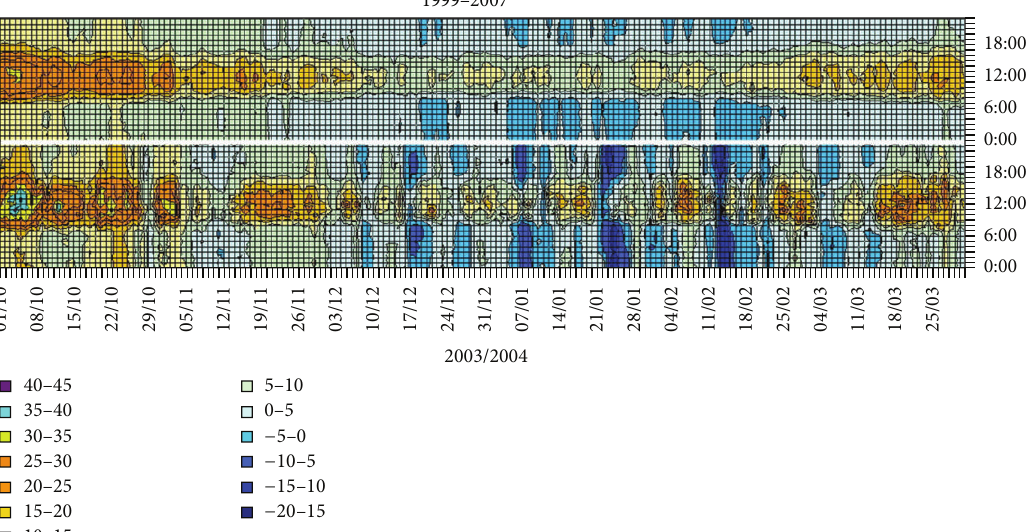
Figure 4: Composite mean hourly variability of PET within the cold period 1999–2007 (upper graph), along with the hourly variability of PET within the cold period 2003-2004 (lower graph).